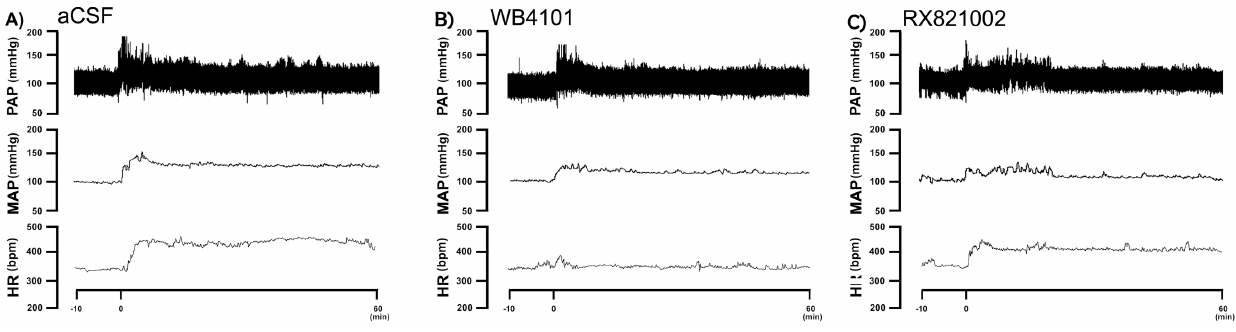
Figure 2. Representative recordings of mean arterial pressure (MAP), pulsatile arterial pressure (PAP) and heart rate (HR) of representative rats submitted to acute restraint stress. A) Recordings of MAP, PAP and HR of one representative rat treated with vehicle (ACSF) into the insular cortex and submitted to acute restraint stress. The onset of restraint is at t=0. B) Recordings of MAP, PAP and HR of one representative rat treated with the selective a 1 -adrenoceptor antagonist WB4101 into the insular cortex and submitted to acute restraint stress. The onset of restraint is at t=0. Note the decrease in the MAP, PAP and HR responses to restraint stress in animals treated with WB4101 into the insular cortex. C) Recordings of MAP, PAP and HR of one representative rat treated with the selective a 2 -adrenoceptor antagonist RX821002 into the insular cortex and submitted to acute restraint stress. The onset of restraint is at t=0. Note the decrease in the MAP and PAP responses to restraint stress in animals treated with RX821002 into the insular cortex.